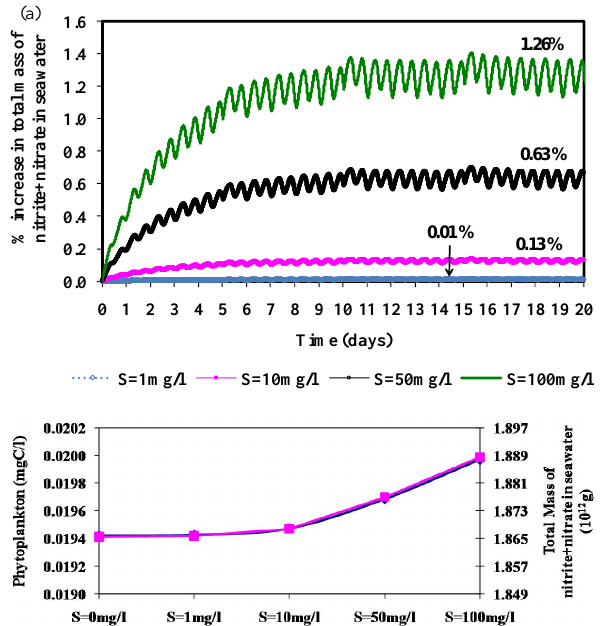
Fig. 5. (a) The percentage increase in total mass of nitrite + nitrate nitrogen in seawater from its baseline and (b) Phytoplankton biomass concentration increase due to various atmospheric nitrate-nitrogen loading in the Singapore Strait. Note: S-Concentration of nitrate-nitrogen from atmosphere and deposition flux = Concentration S multiplied by the annual average rainfall of 2136 mm in the model region.